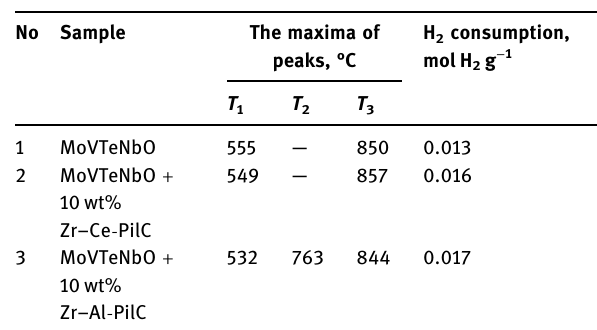
Table 4: Characteristics of H 2 - TPR